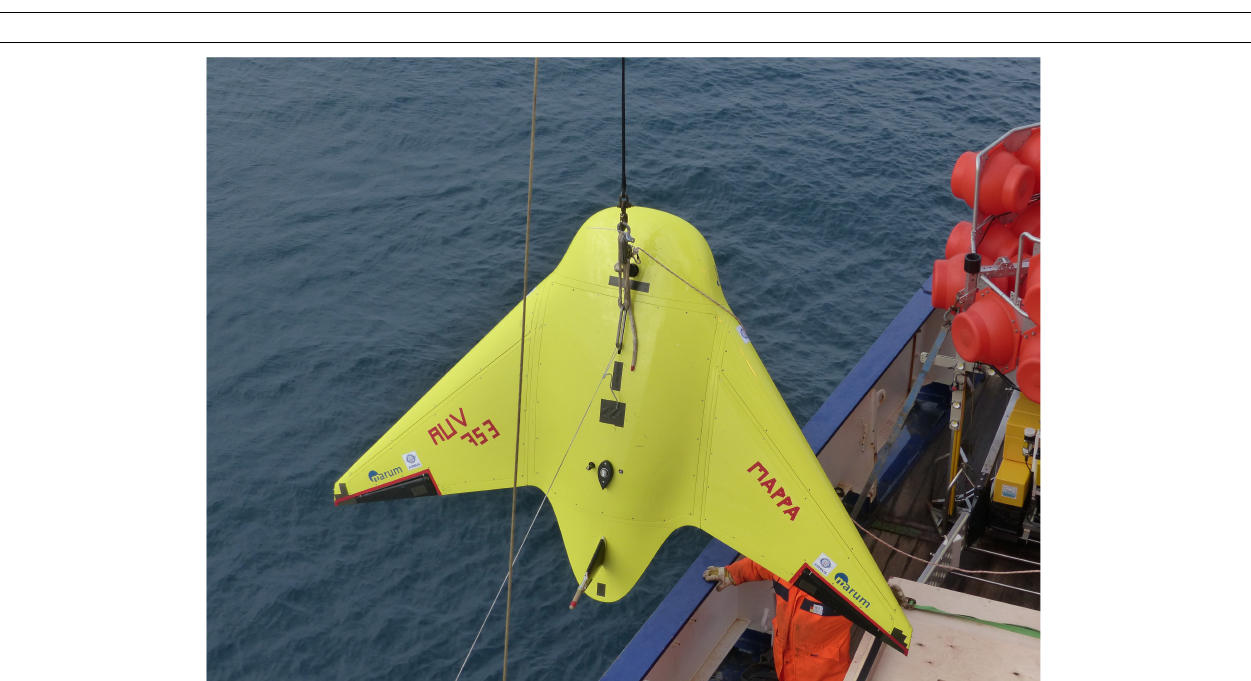
FIGURE 3 | The Blended-Wing glider designed as part of the ROBEX project (© Christoph Waldmann, MARUM, a cooperation project between MARUM and Airbus with support by MBARI).